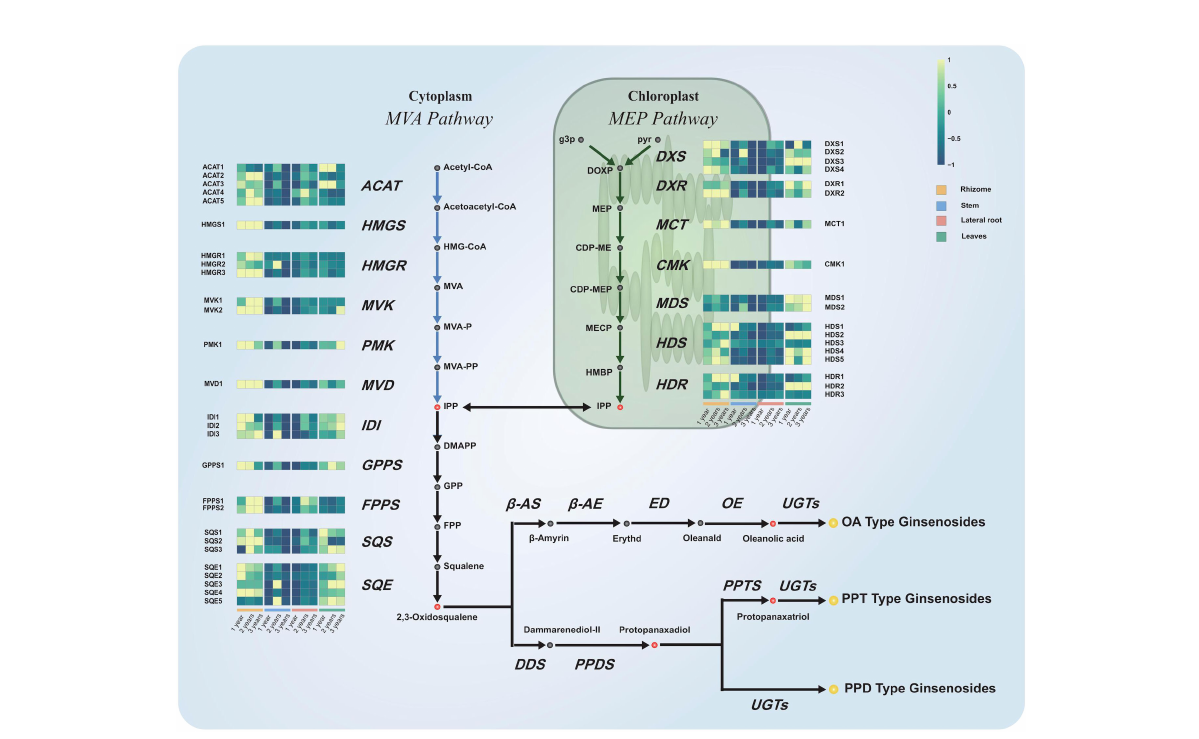
FIGURE 4 Expression pro fi les of genes in the ginsenoside biosynthetic pathway. Schematic representation of ginsenosides biosynthetic pathway and the expression pro fi le of those transcripts of the P. japonicus species which coding for the enzymes involved. The grey, red, and yellow circles marked the proposed intermediates, precursors, and ginsenosides in the biosynthetic pathway of ginsenosides. The enzymes (acronyms shown in italics) involved in the ginsenosides biosynthetic pathway and their corresponding orthologs identi fi ed in the P. japonicus transcriptome were represented. Expression pro fi les represent the abundance of the transcripts (FPKM) in each tissue from different growth years.